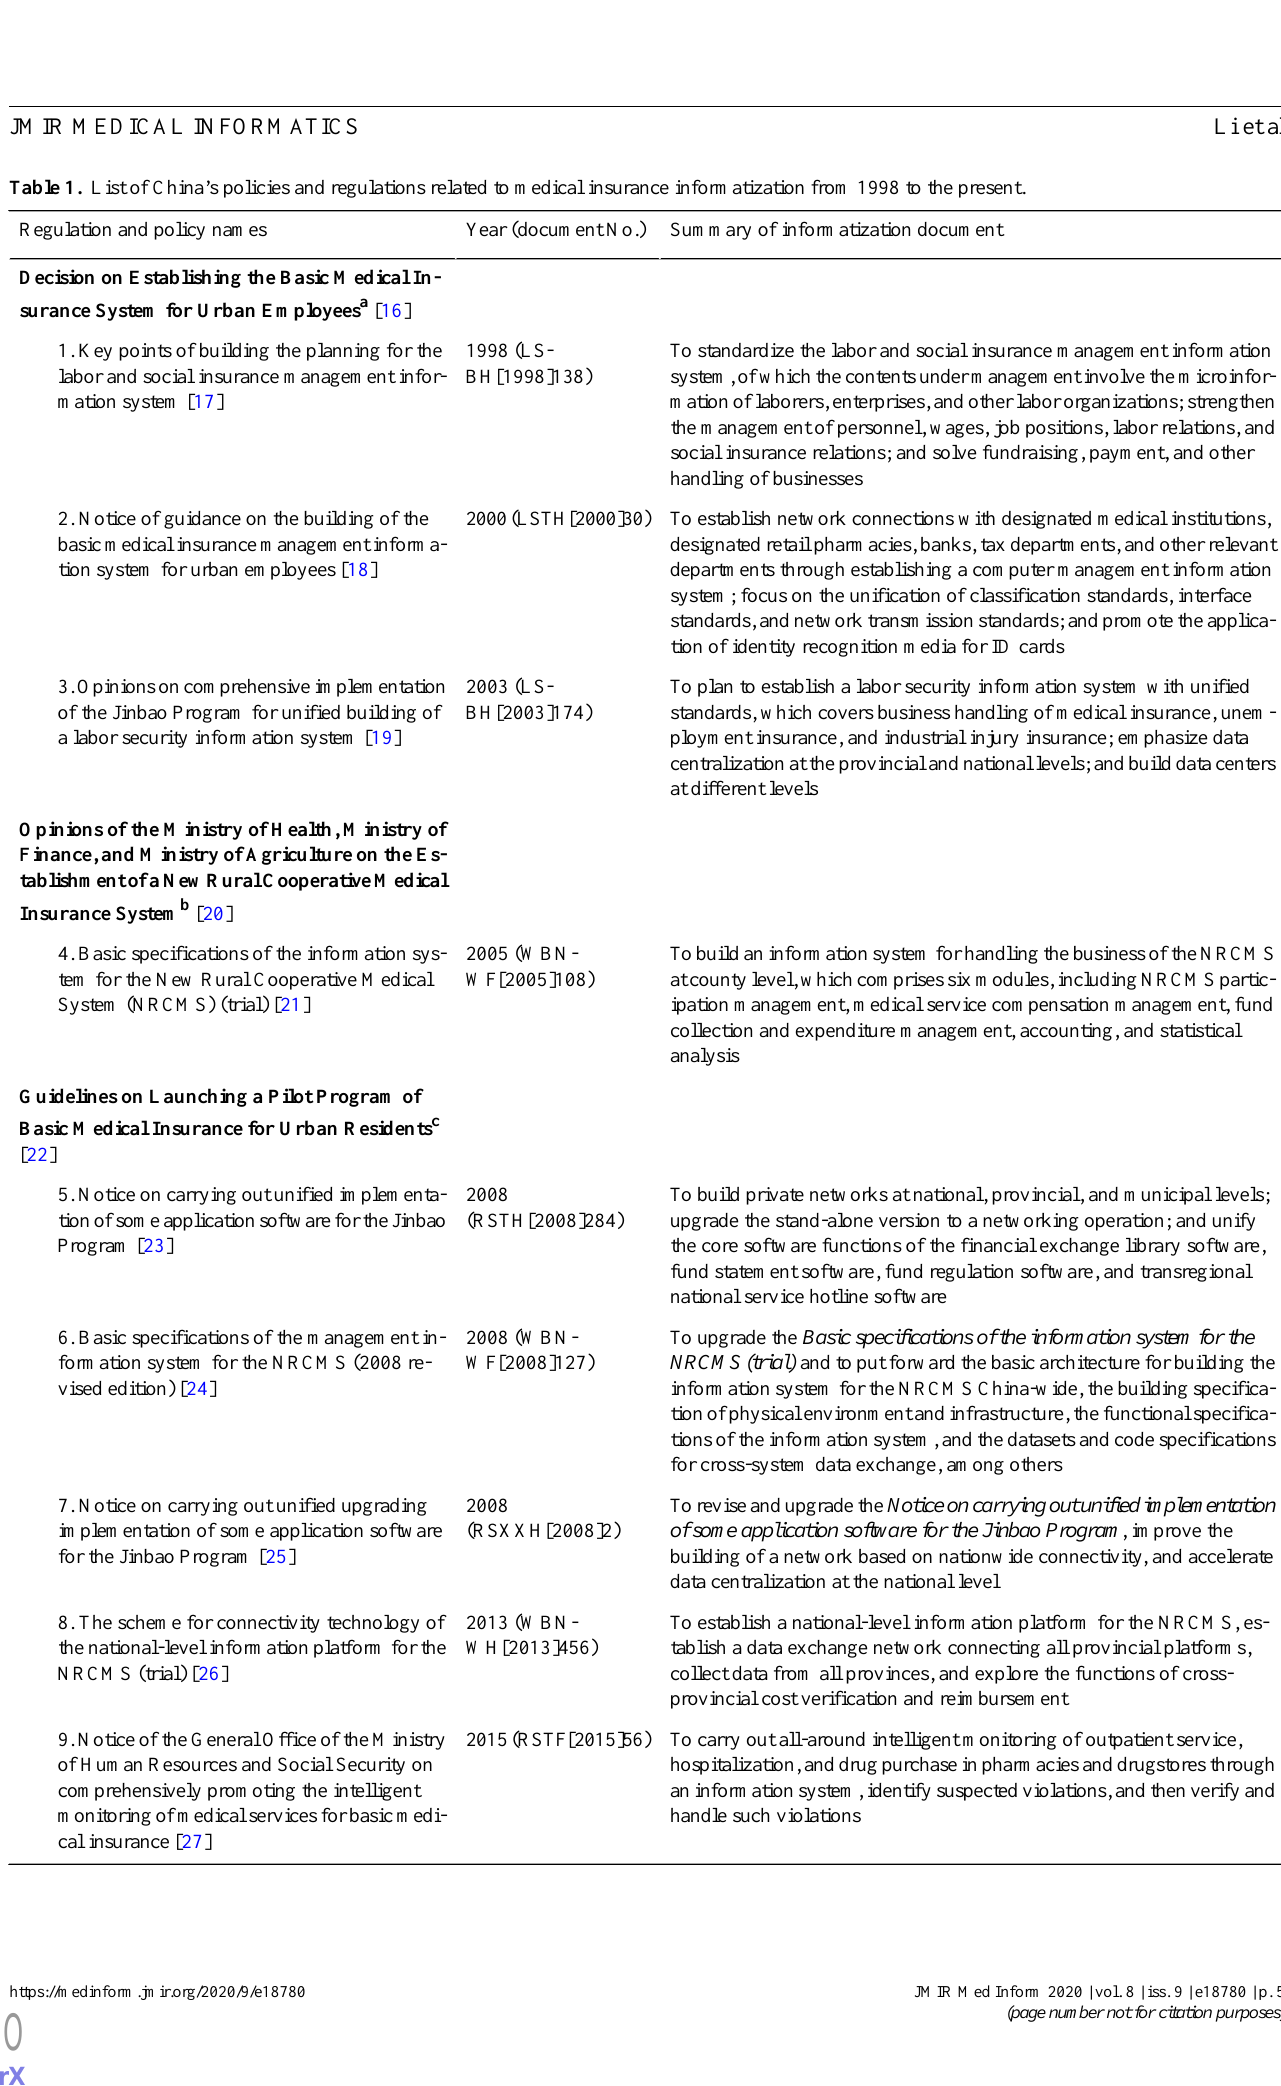
Table 1. List of China’s policies and regulations related to medical insurance informatization from 1998 to the present.